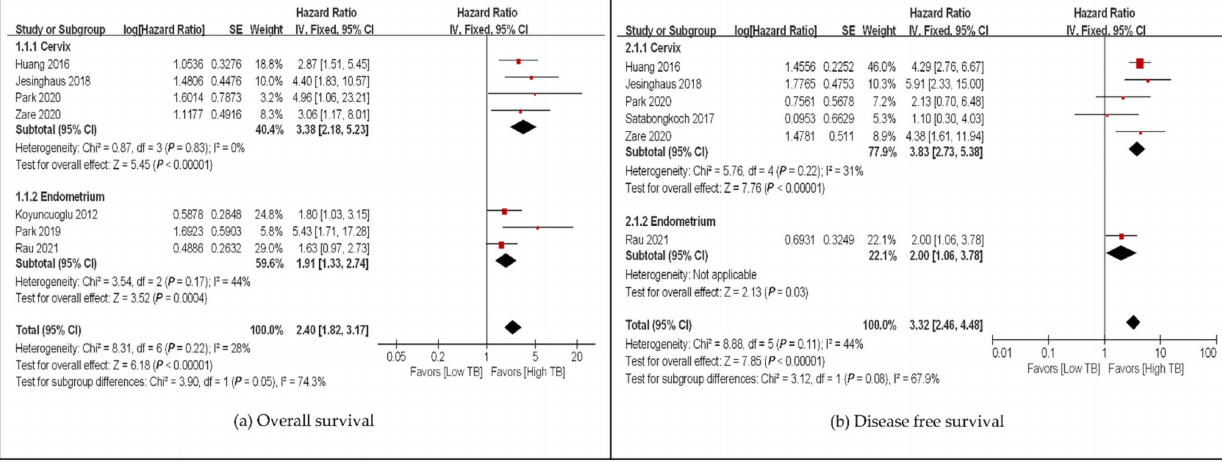
Figure 2. Subgroup hazard ratios analyzing the tumor budding expression, ( a ) overall survival, ( b ) disease-free survival in gynecological cancer patients by organs. (cid:4) The location of square epresents the hazard atio and the size means individual effect of studies. The black line represents 95% confidence iterval of the study. (cid:117) The diamond represents pooled hazard ratio and its edge shows 95% confidence interval.